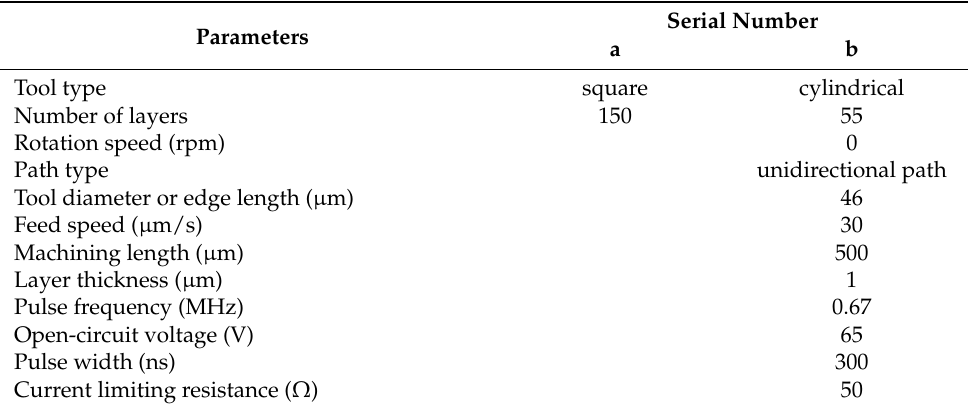
Table 5. Machining parameters for Exp. 3.